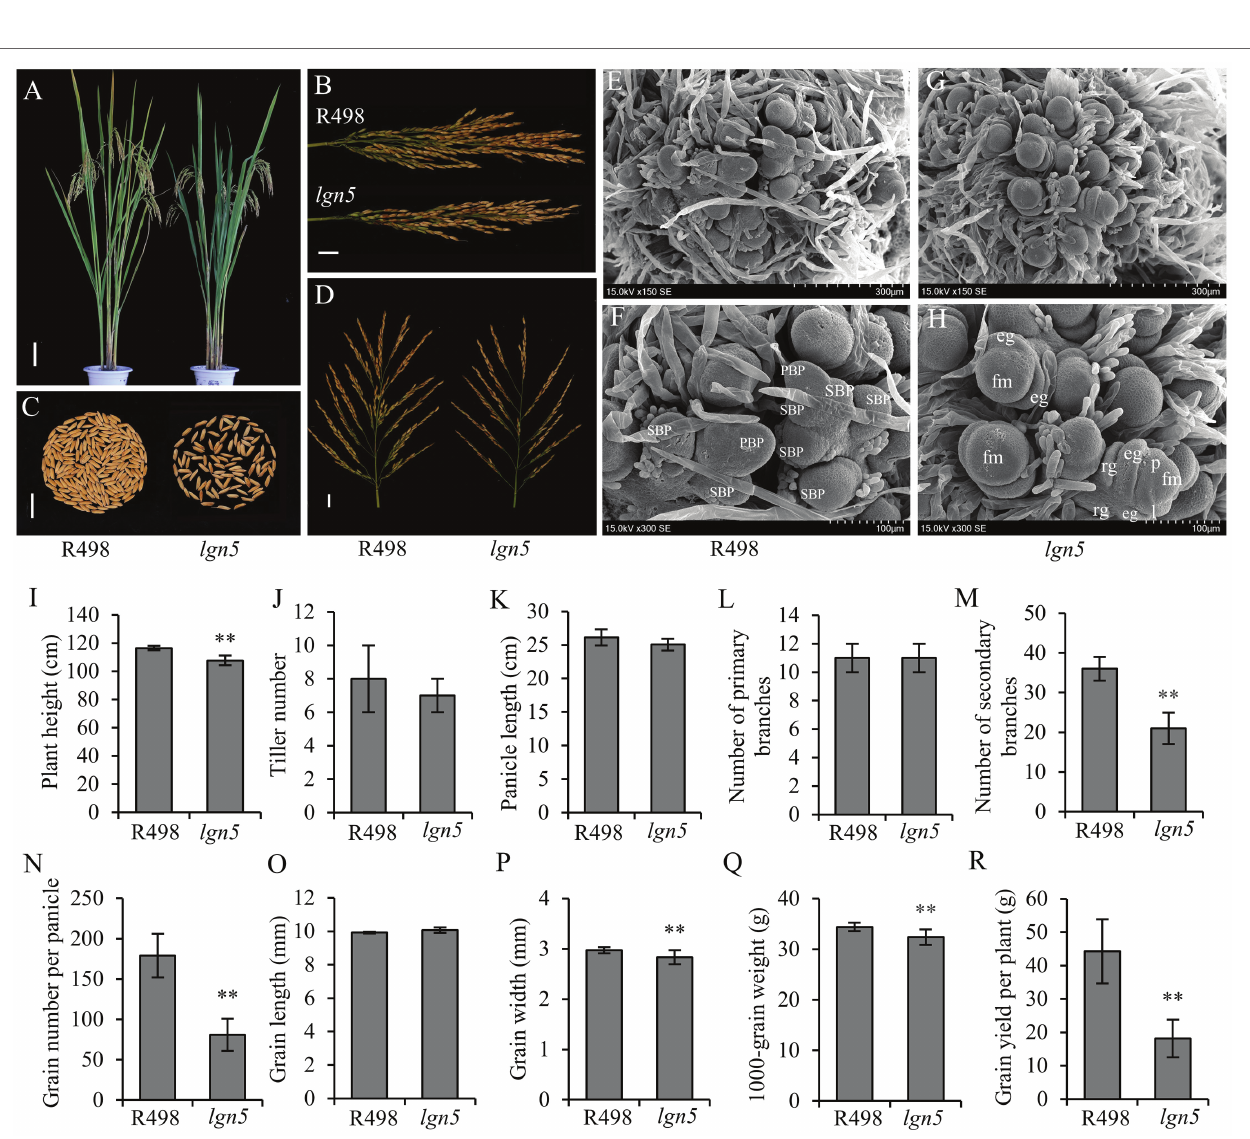
FIGURE 1 | Phenotype of less grain number 5 ( lgn5 ) mutant. (A) Plant morphology of R498 and lgn5 during grain filling. Scale bar: 10 cm. (B) Panicles of R498 and lgn5 . Scale bar: 2 cm. (C) Comparison of grain number per panicle (GNP) between R498 and lgn5 . Scale bar: 2 cm. (D) Panicle morphology of R498 and lgn5 . Scale bar: 2 cm. (E–H) Scanning electron microscopy (SEM) observation of the young panicle in the early developmental stage between R498 and lgn5 . (E,G) Young panicle of 0.5–1 mm. (F,H) Enlarged views of (E,G) , respectively. PBP, primary branch primordia; SBP, secondary branch primordia; fm, floral meristem; p, palea; l, lemma; eg, empty glume; rg, rudimentary glume. Scale bar: 300 μ m (E,G) and 100 μ m (F,H) . (I–R) Statistical analysis of major agronomic traits in R498 and lgn5 . Data are given as means ± SD of five biological replicates. ** indicates p < 0.01 by Student’s t